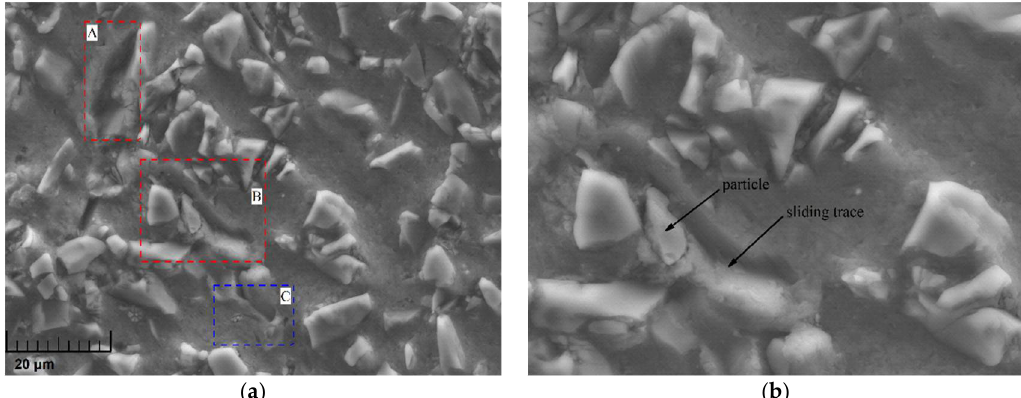
Figure 11. Local micromorphology of a specimen at 1600 s −1 under the 350 °C condition. ( a ) Morphological characteristics: particle sliding (A, B) and matrix flowing (C); ( b ) detailed morphology in region B.